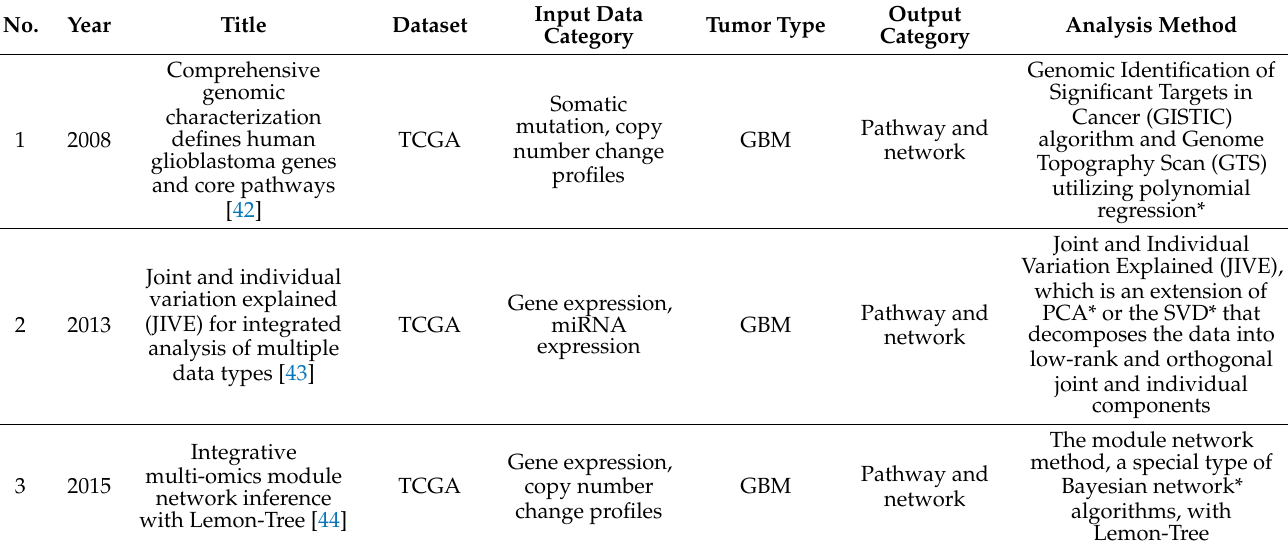
Table 1. Summary of the studies short-listed for this